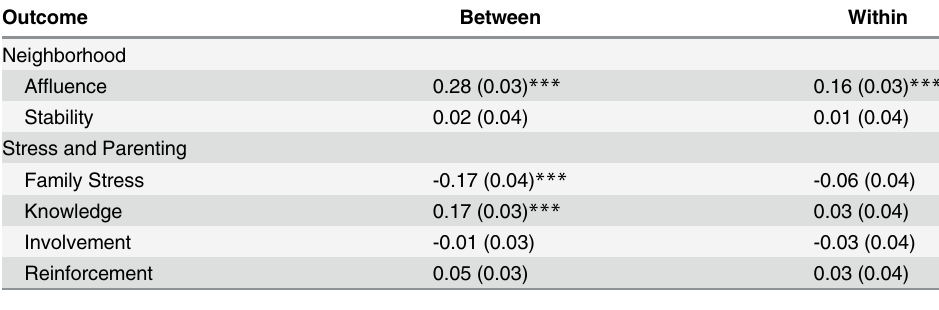
Table 6. Subsequent Regression Models for the Effect of Family SES on Neighborhood Quality and Parenting. Note . Unstandardized regression coefficient with standard errors in parentheses. Control vari- ables omitted from table: single caretaker, ethnicity, age dummies, and wave dummy. Outcome Between Within Neighborhood Af fl uence 0.28 (0.03) *** 0.16 (0.03) *** Stability